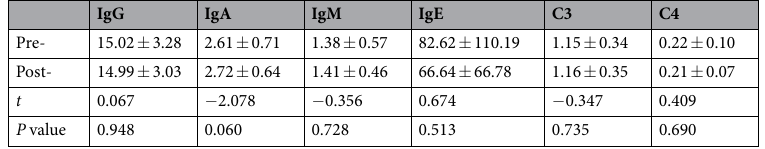
Table 4. The immunity items pre- and 1 months post- iodine-125 brachytherapy of the 2 subgroups